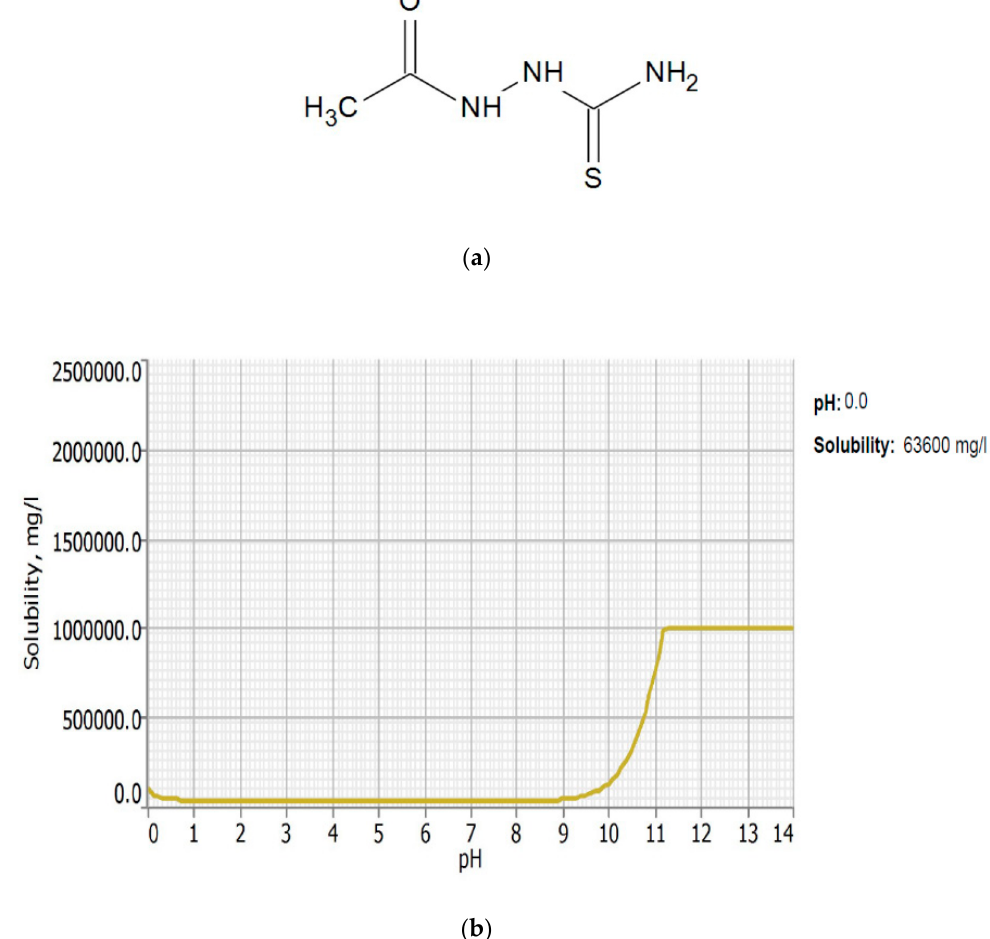
Figure 1. Molecular structure ( a ) and the solubility vs. pH ( b ) of 1-acetyl-3-thiosemicarbazide (AST).